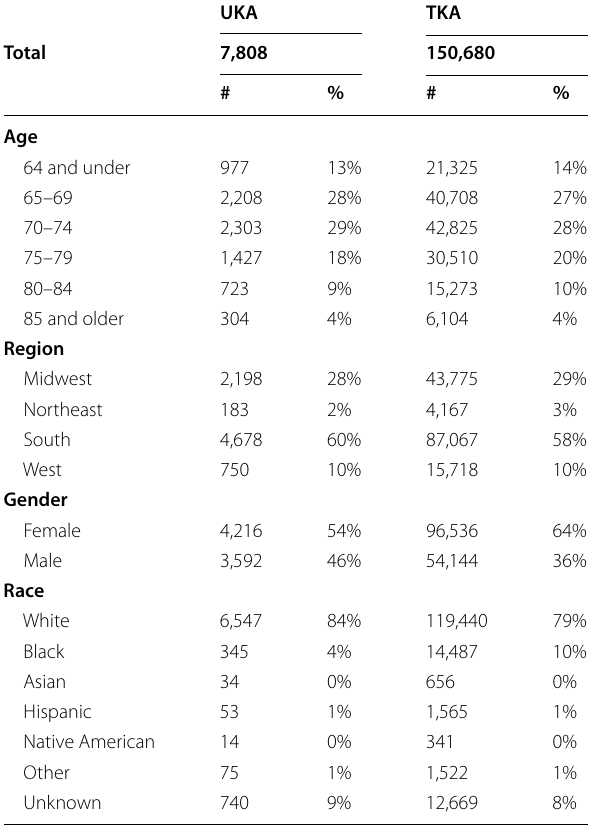
Table 1 All patients who underwent UKA and TKA during the study period